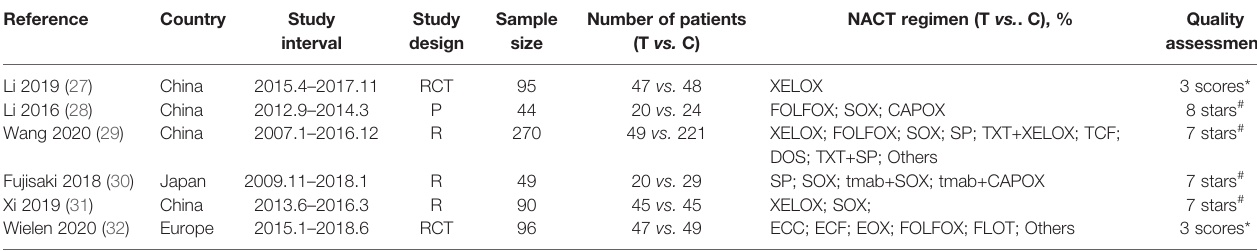
TABLE 1 | Basic characteristics of included